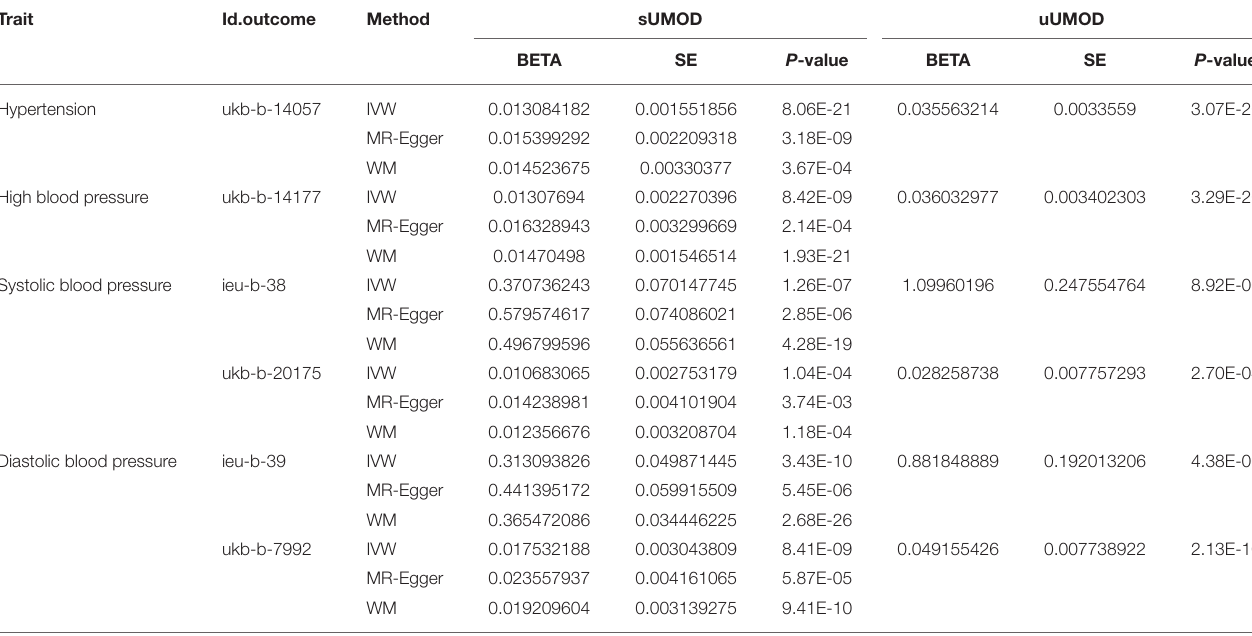
TABLE 1 | The outcomes of two-sample Mendelian randomization.